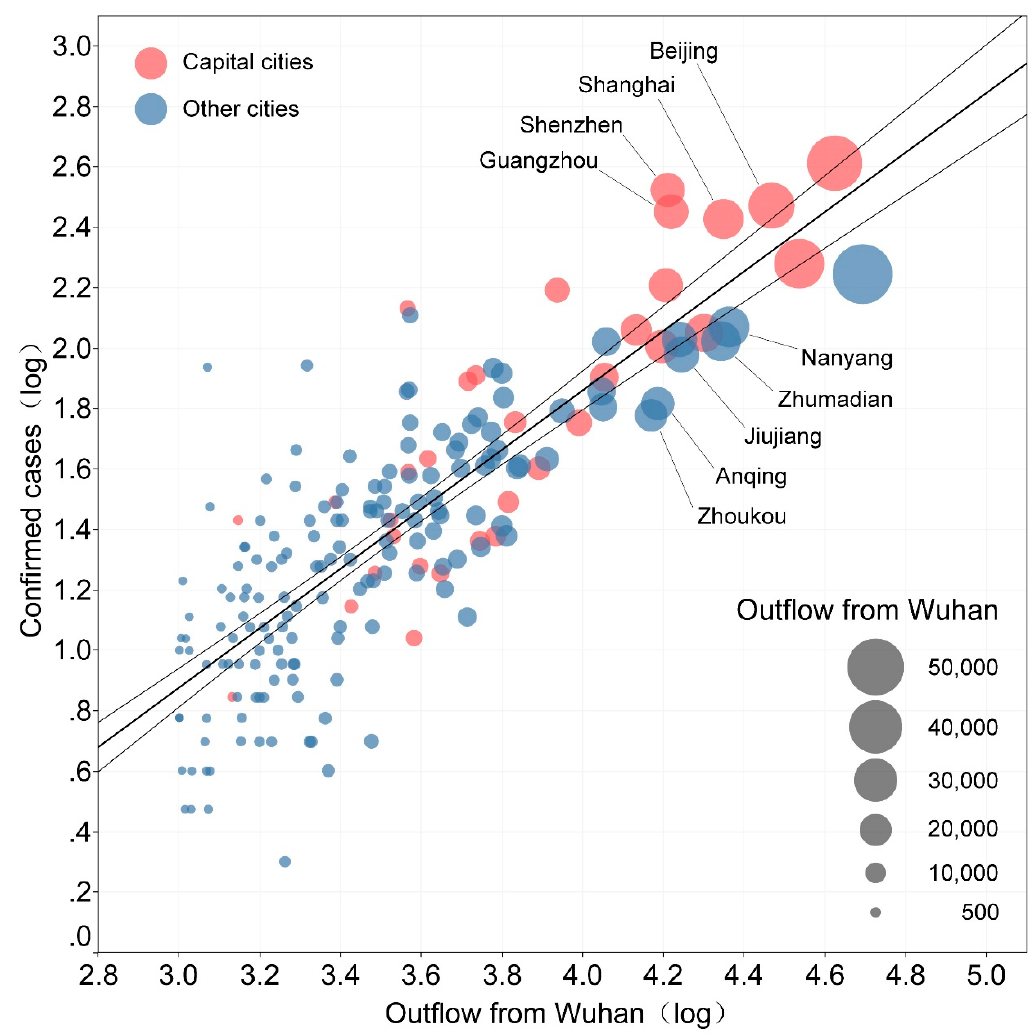
Figure 4. The correlation between population outflow from Wuhan and cumulative confirmed COVID-19 cases.